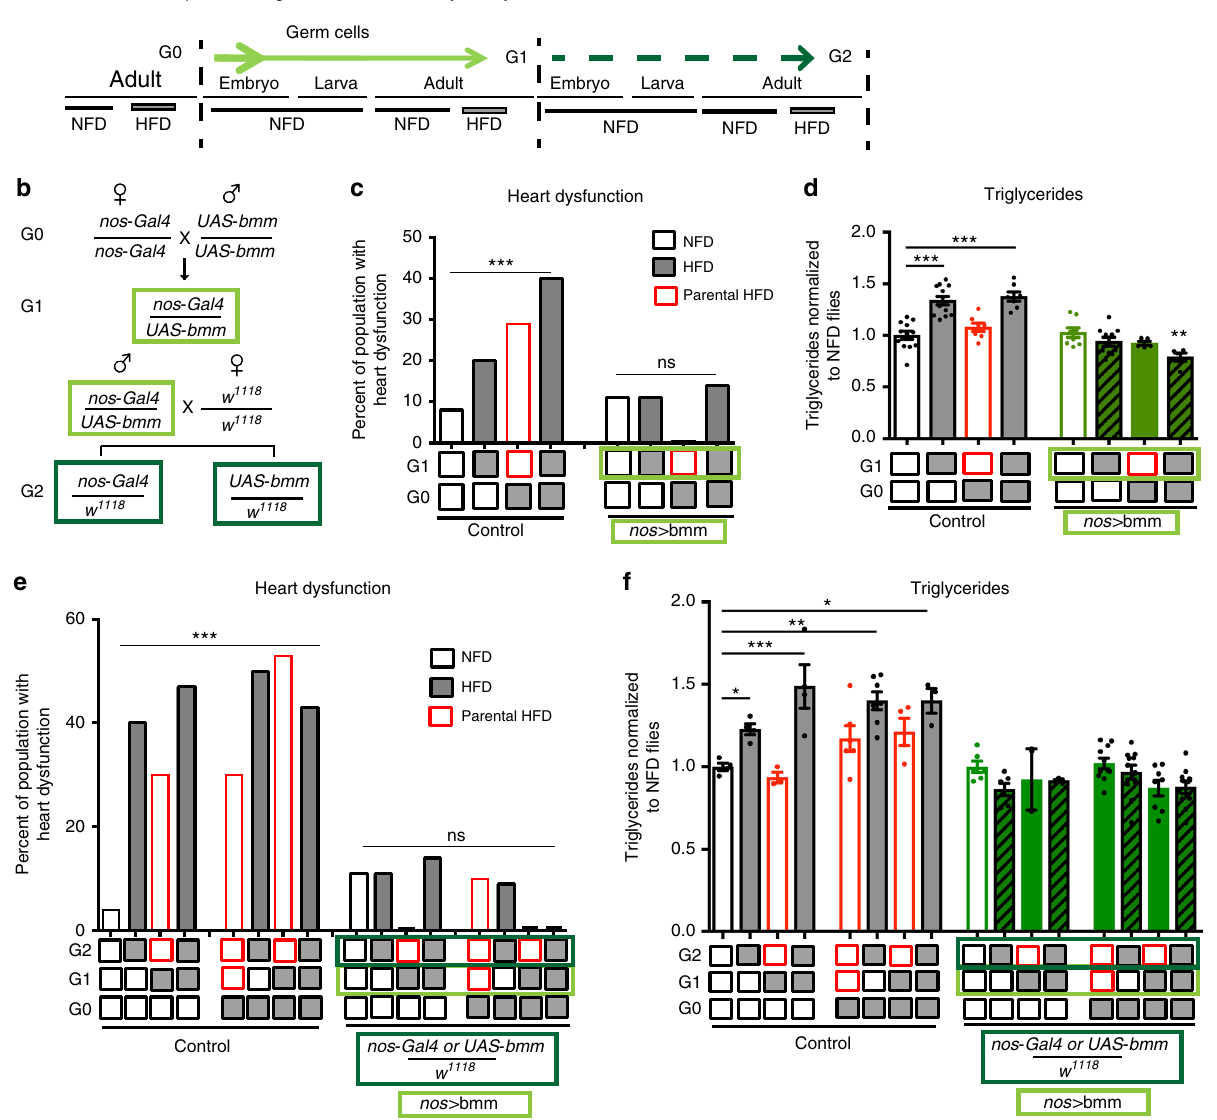
Fig. 5 Early embryonic and future germ cell expression of bmm lipase protects the progeny and their offspring from the effects of parental or acute exposure to a HFD. a Schematic of the germline expression Gal4 driver, nos -Gal4 (green arrow). nos -Gal4 is expressed in the maternal germline and localized in the posterior region of the maturing oocytes, persists until the early embryonic stages to turn on UAS-containing target genes. In these embryos, nos -driven Gal4 is only expressed in the germline (future germ cells 28 ) that give rise to the following generation. b Mating scheme of early embryonic Gal4 driver, nos -Gal4, to UAS-bmm . c Cumulative incidence of heart dysfunction and d TAG content in G1 adult fl ies after acute or parental exposure to NFD or HFD. bmm expression in the early embryo and future germ cells protected against HFD-associated heart dysfunction and